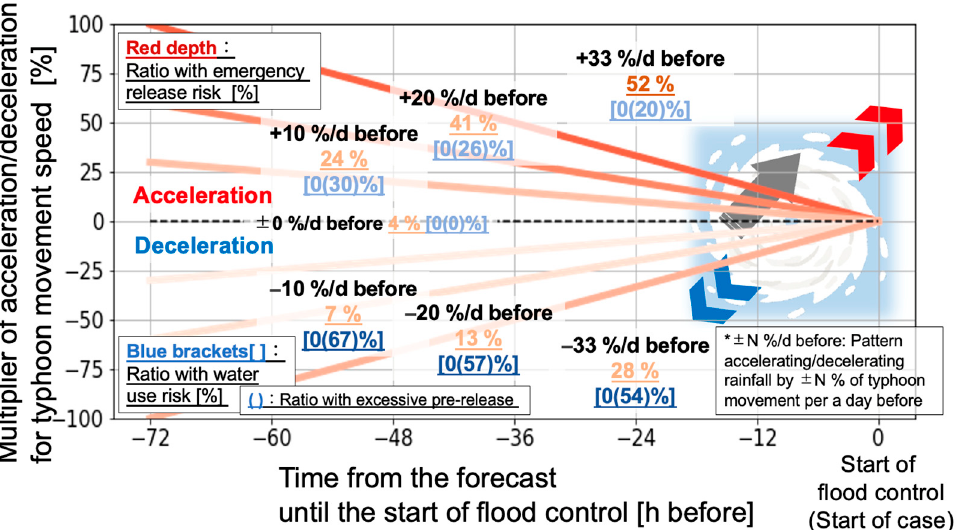
Figure 23. Another version of Figure 22 shown on the forecast pa tt erns’ variations. Ratio ( %) of cases with an emergency release risk in all pre-release typhoon cases (red) and water use risk in all pre-release and quasi-pre-release typhoon cases (in blue square brackets) (excluding exceptions) when using rainfall forecasts with the acceleration/deceleration of rainfall zone. ±N %/d before: a pa tt ern accelerating/decelerating rainfall by ±N % of typhoon movement per a day before.